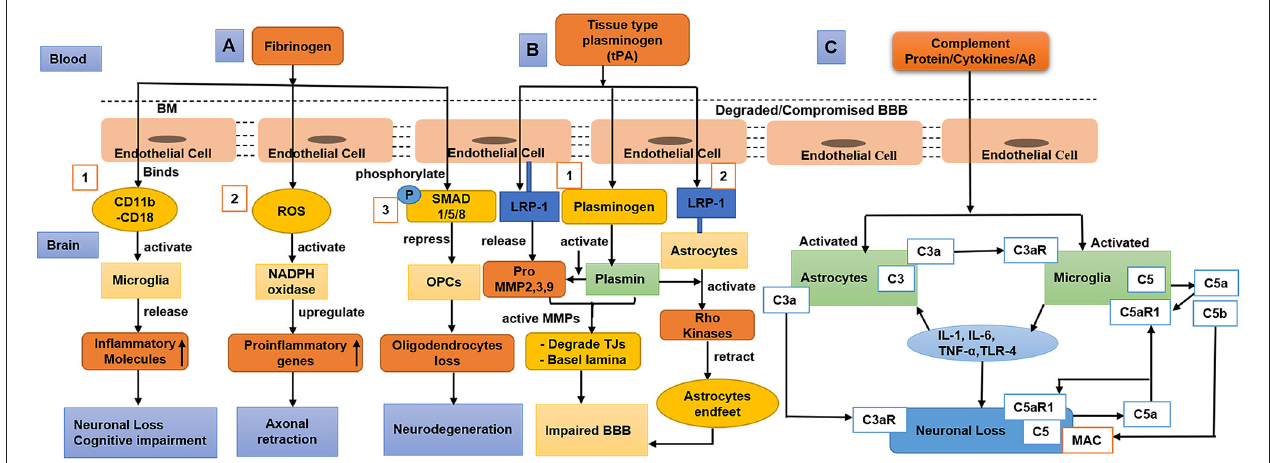
FIGURE 3 | Diagram that shows fibrinogen, tissue-type plasminogen activator (tPA), plasmin, and complement proteins/cytokines/A β cross compromised the blood–brain barrier (BBB), causing neuronal loss and decline in cognition. (A) (1) Fibrinogen activates the microglia via CD11b/CD18, which releases inflammatory/toxic molecules causing neurodegeneration and cognitive impairment. (2) Fibrinogen induces reactive oxygen species (ROS), activates nicotinamide adenine dinucleotide phosphate (NADPH oxidase), and upregulates proinflammatory genes causing axonal retraction and cognitive impairment. (3) Fibrinogen phosphorylates SMAD 1/5/8 and represses oligodendrocyte progenitor cells (OPCs) leading to oligodendrocyte loss. (B) (1) tPA binds with low-density lipoprotein receptor-related protein-1 (LRP-1) of endothelial cells (ECs), which secretes pro-matrix metalloproteinases (MMPs). tPA activates plasminogen into plasmin, which further activates pro-MMPs that degrade tight junctions (TJs) and basal lamina. (2) tPA also binds with the LRP-1 of astrocytes, induces plasmin mediated activation of Rho kinase, and results in astrocyte retraction leading to BBB impairment. (C) During aging and dementia such as Alzheimer’s disease (AD), complement proteins, oxidative stress, and the aggregated amyloid-beta (A β ) activate the astrocytes and microglia, leading to neuroinflammation. The C3aR and C5aR1 signalings on activated microglia cause the release of cytokines [IL-1, IL-6, tumor necrosis factor- α (TNF- α ), and toll-like receptor 4 (TLR-4)] and result in neurodegeneration. To aggravate neuronal apoptosis, C5a as a neuronal-derived signal that interacts with C5aR1 on neurons in an autocrine way. Furthermore, C3a as an astrocytic-derived signal binds to C3aR on neurons to exacerbate neuronal morphology. During neuroinflammation, microglia-derived C5b binds with the membrane attack complex (MAC) that enhances neuronal